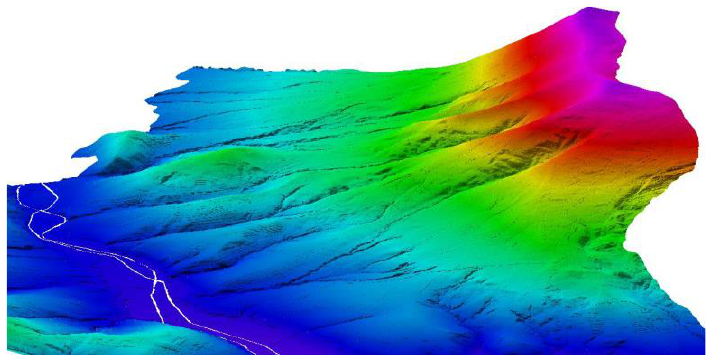
Figure 29. Isometric view of the generated surface.